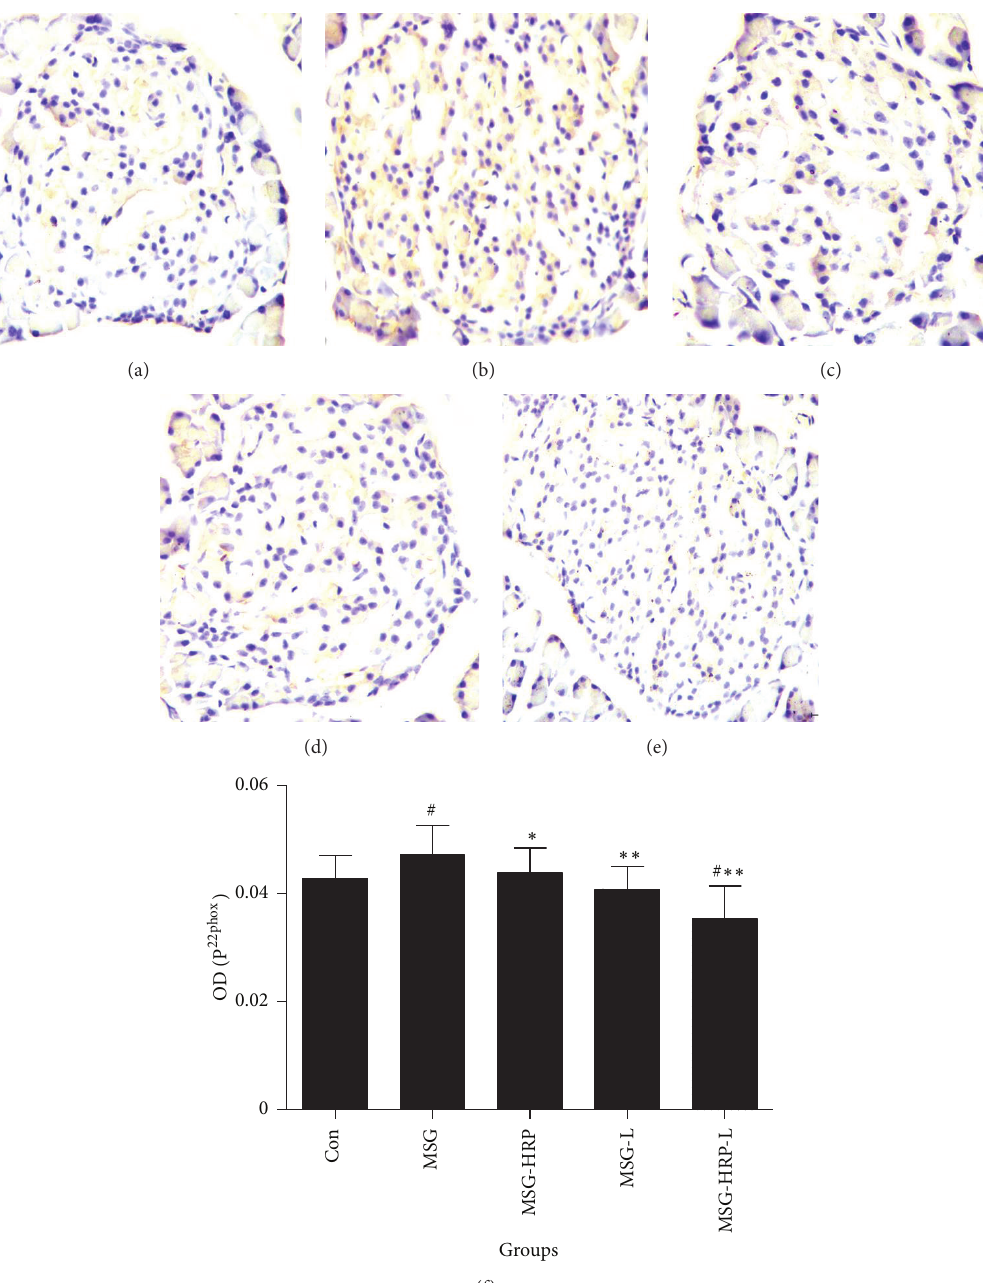
Figure 7: Immunostaining of P 22 phox in the pancreatic islets ((a)–(e), × 400) and the average gray-scale intensities of staining (f). The immunostaining of P 22 phox increased in the MSG group when compared with the Con group. Treatment with losartan, HRP, and both decreased the average gray-scale intensities of immunostaining of P 22 phox . (a) Con; (b) MSG; (c) MSG-HRP; (d) MSG-L; (e) MSG-HRP- L. ∗ Compared with MSG group, 𝑃 < 0.05 ; ∗∗ compared with MSG group, 𝑃 < 0.01 ; # compared with Con group, 𝑃 < 0.05 .